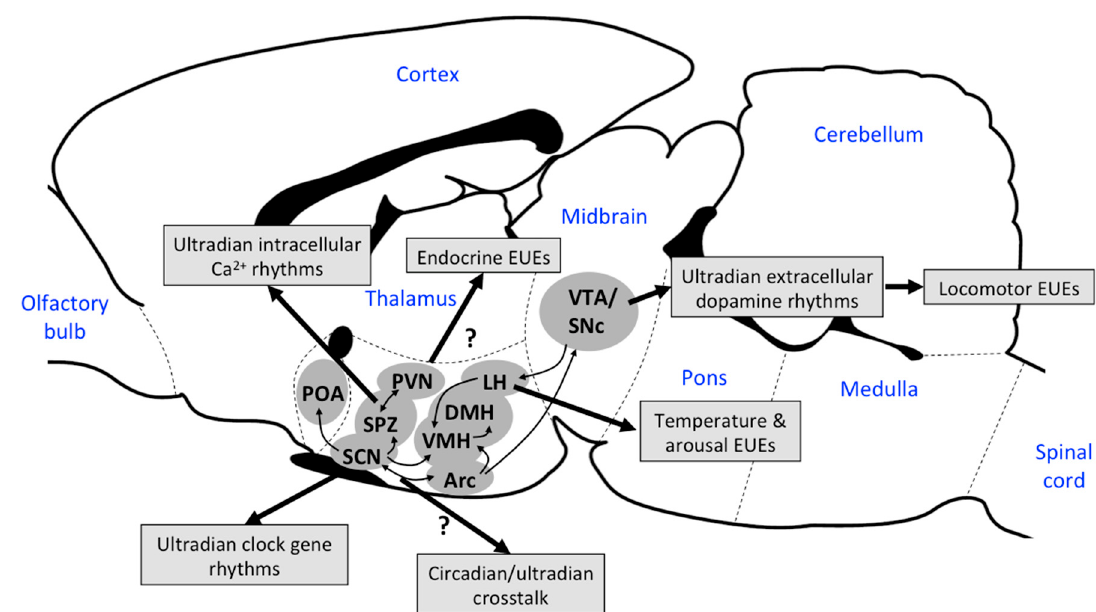
Figure 5. Schematic of the key regions involved in the regulation of EUEs approximated in the rat brain [81]. Major neuronal connections are shown in black arrows and demonstrate a putative network that generates and/or coordinates physiological EUEs. A midbrain dopaminergic oscillator in the VTA/SNc region appears largely responsible for generating EUEs in locomotion [82]. Orexin neurons in the lateral hypothalamus are implicated in generating EUEs of body temperature, arousal and locomotion, but not feeding and heart rate [83]. The pathways connecting the SCN with the ARC and the SPZ may represent sites of crosstalk between the ultradian and circadian systems. The SPZ-PVN region generates EUEs in intracellular calcium levels [84], and EUEs in clock gene expression in the SCN have been observed [34]. The parvocellular and magnocellular neurons in the PVN may regulate endocrine EUEs. However, the functional significance of ultradian clock gene rhythms in the SCN remains unclear.